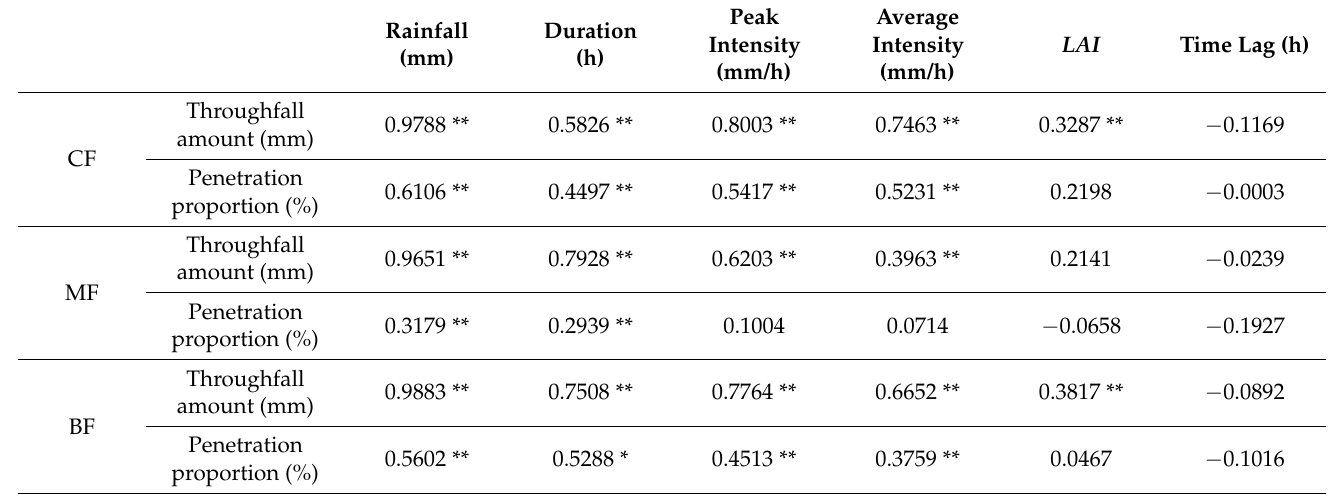
Table 2. Pearson correlations among throughfall, rainfall parameters, and LAI